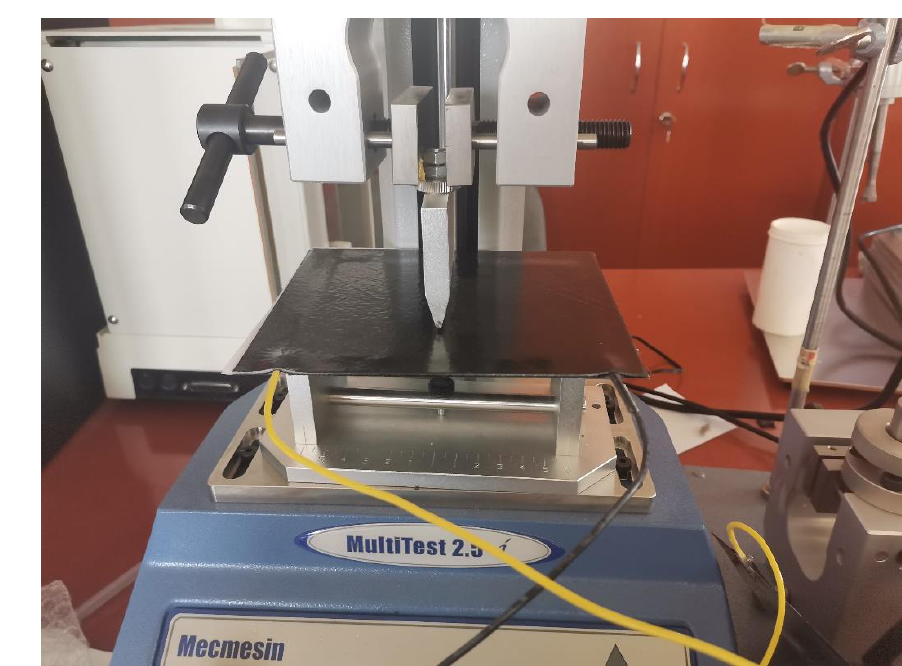
Figure 12. The profile of the random vibration used for testing.